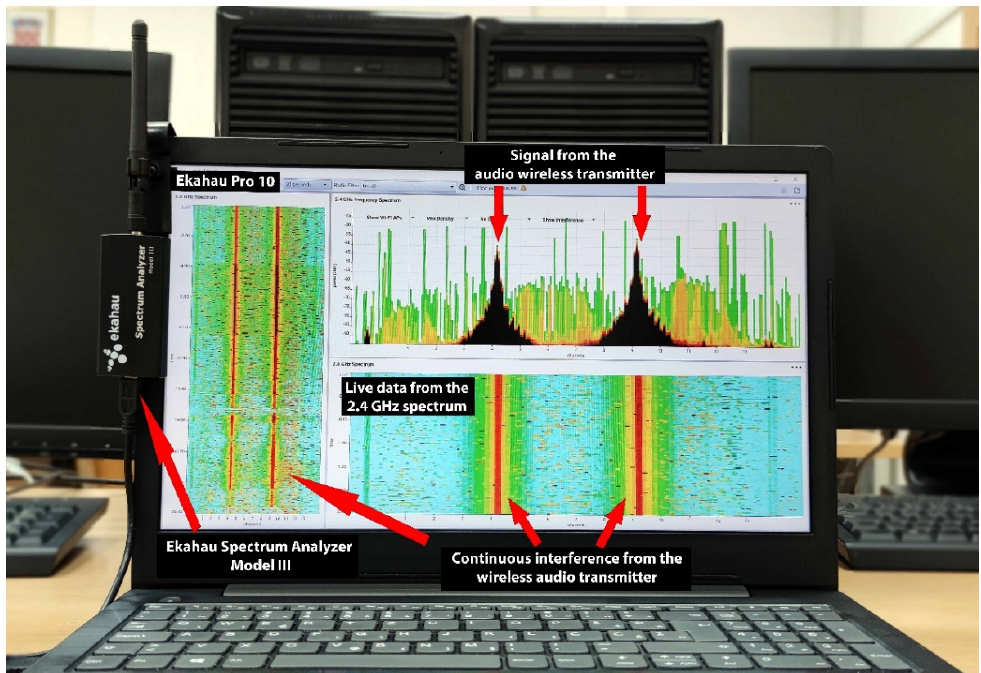
Figure 4. Spectrum analyzer comprising an Ekahau Spectrum Analyzer Model III and Ekahau Pro 10 software. The image shows data collected during a preliminary network run in the presence of interference.